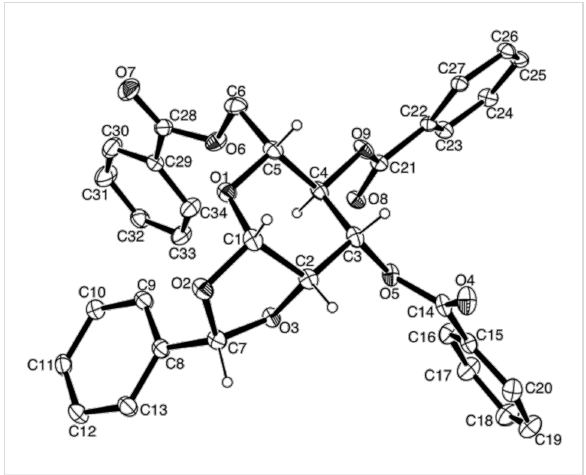
Figure 3: ORTEP plot of single crystal X-ray determination of (7 S )- 18 . Thermal ellipsoids denote 20% electron probability.